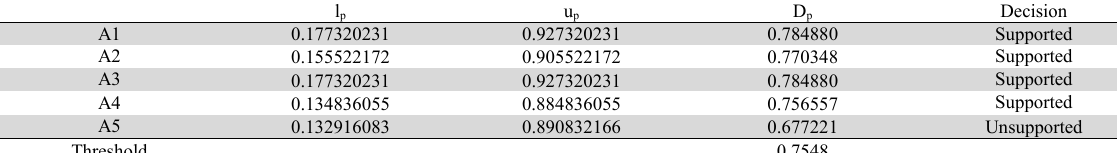
FDM for aspects